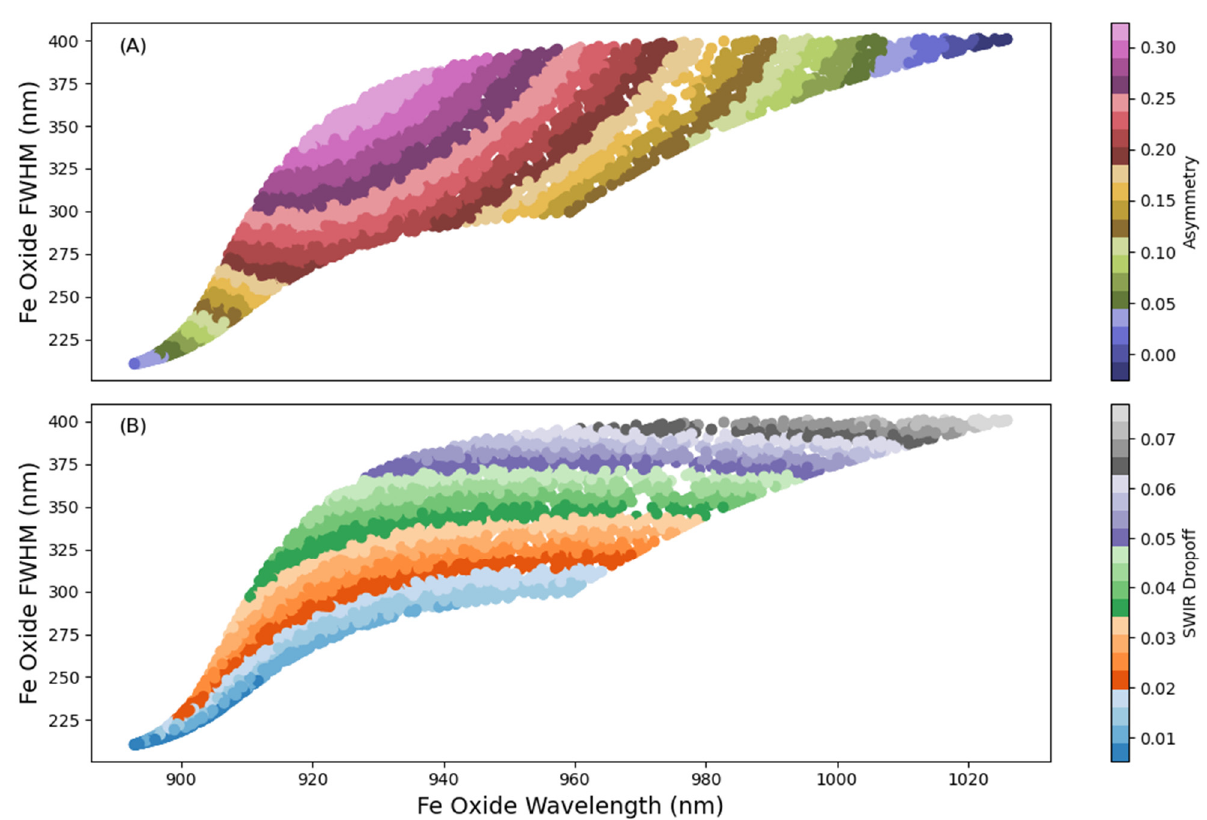
Figure 5. The iron boomerang coloured by the 2 additional spectral parameters that are used in prediction modelling. ( A ) is coloured by the Fe Oxide Asymmetry where a value of 0 is symmetrical and 1 is right skewed. ( B ) is coloured by the SWIR drop-off between 1550 nm–1850 nm and increases as vitreous goethite increases. Refer to Figure 4 for how the 4 metrics are calculated.